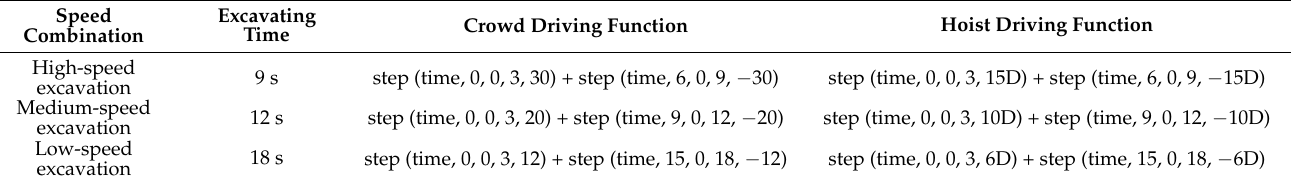
Table 5. Driving function